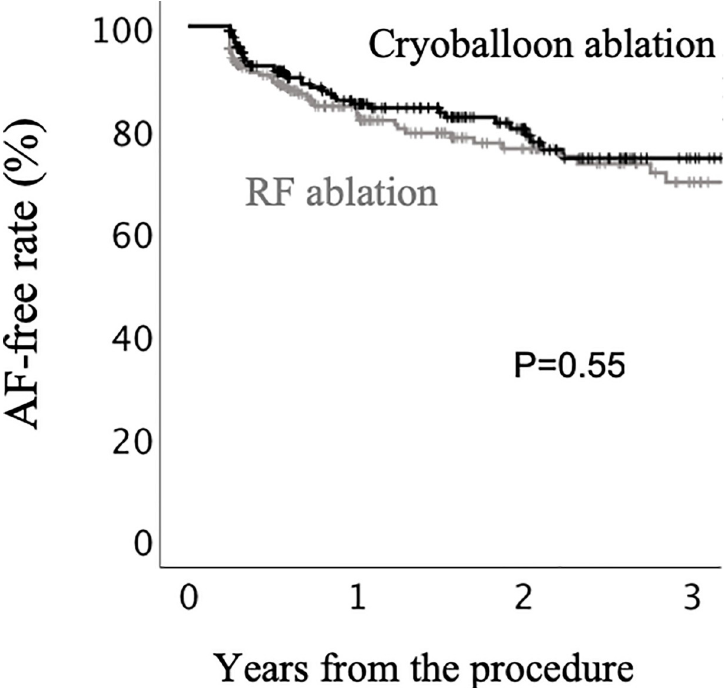
Fig 1. The AF-free rate after initial cryoballoon (CB) or radiofrequency (RF) ablation. Kaplan-Meier curves showing the AF-free rate after the initial CB and RF catheter ablation procedure.